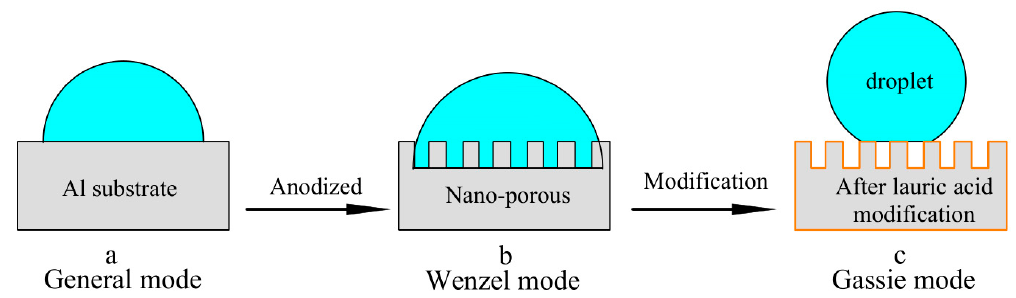
Figure 4. Scheme for the preparation of the superhydrophobic surface and a self-assembled lauric acid layer at the surface of the prepared plates.